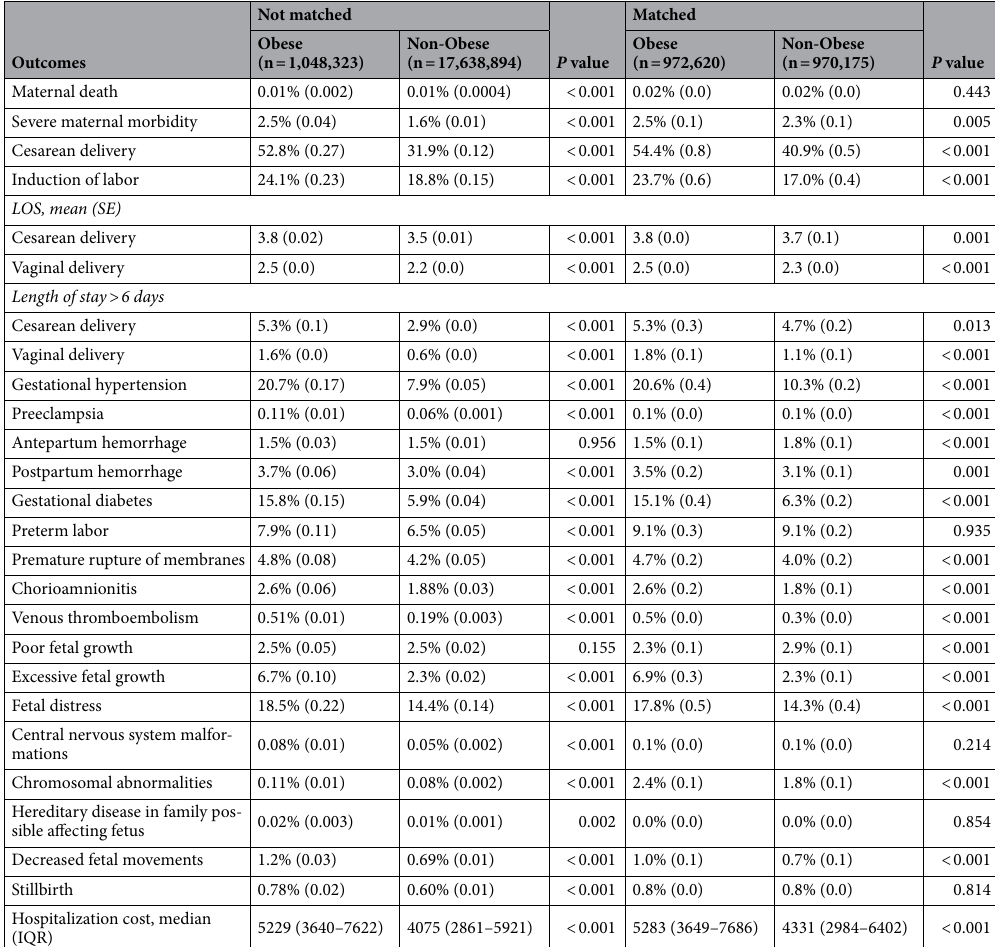
Table 3. Obstetrical outcomes among obese and non-obese pregnant